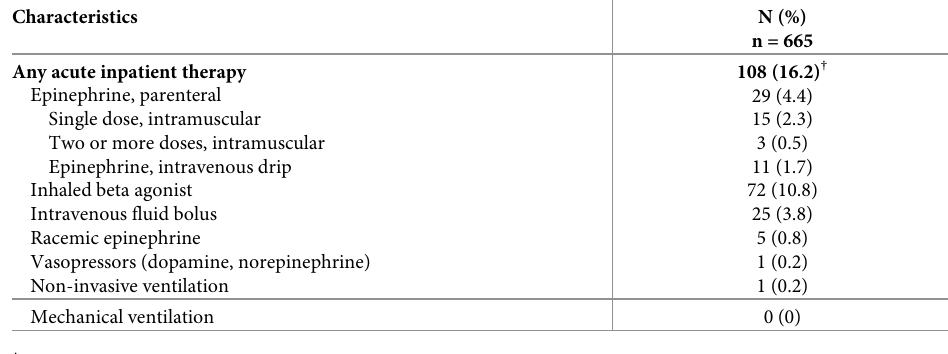
Table 2. Receipt of acute inpatient therapies among children hospitalized with anaphylaxis.